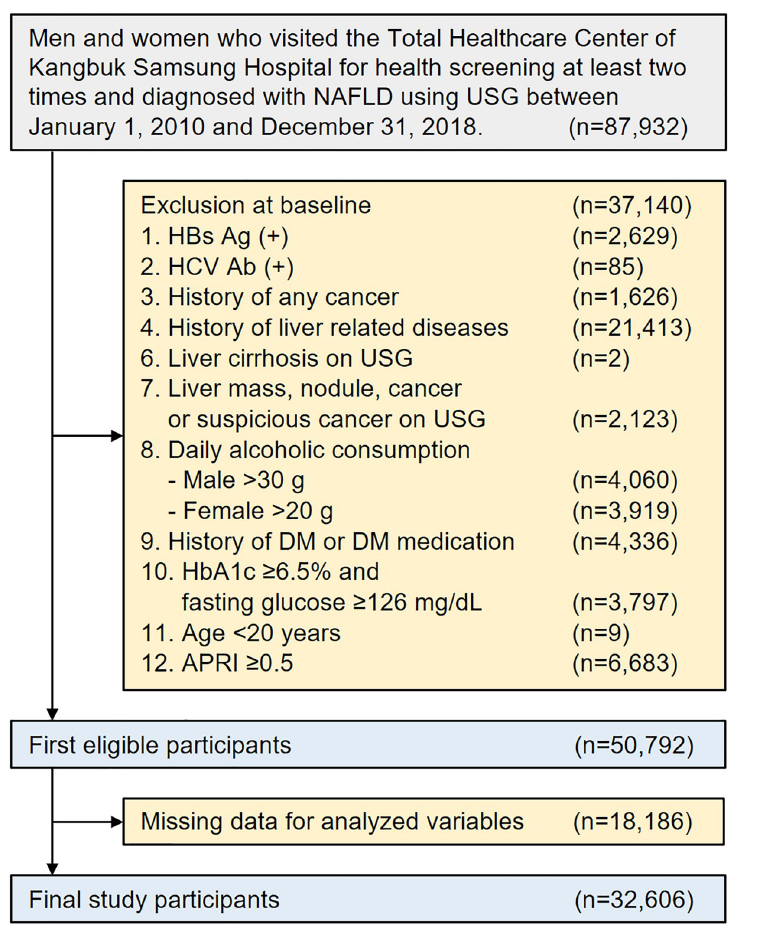
Fig 1. Flow chart of study participants. Abbreviations: NAFLD, nonalcoholic fatty liver disease; USG, ultrasonography; DM, diabetes mellitus; APRI, aspartate aminotransferase-to-platelet ratio index.